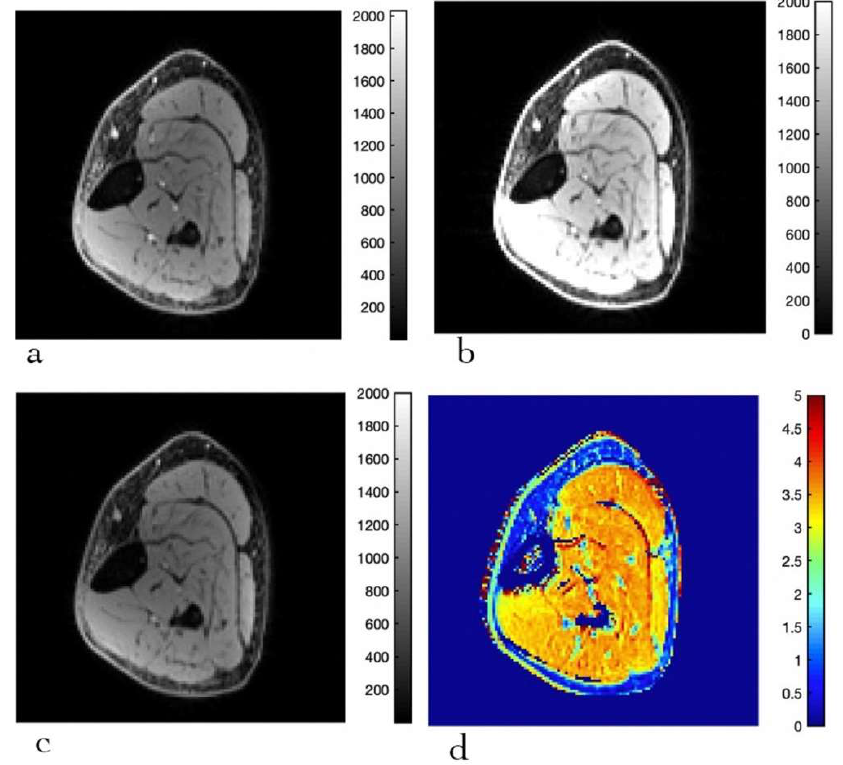
Figure 3. Typical acquired and computed images of the calf muscle for MT sat mapping (senior sub- ject): 10° flip angle with MT pulse (magnetization transfer weighted, MT) ( a ), 20° flip angle (T1- weighted, T1) ( b ), 4° flip angle (proton density weighted, PD) ( c ), MT sat map ( d ). The legend for the colormap for each image is shown next to it. The units for the acquired images are arbitrary units ( a – c ), and for the MT sat in % units ( d ). Table 2. Regional muscle MT sat values for young and senior cohorts.